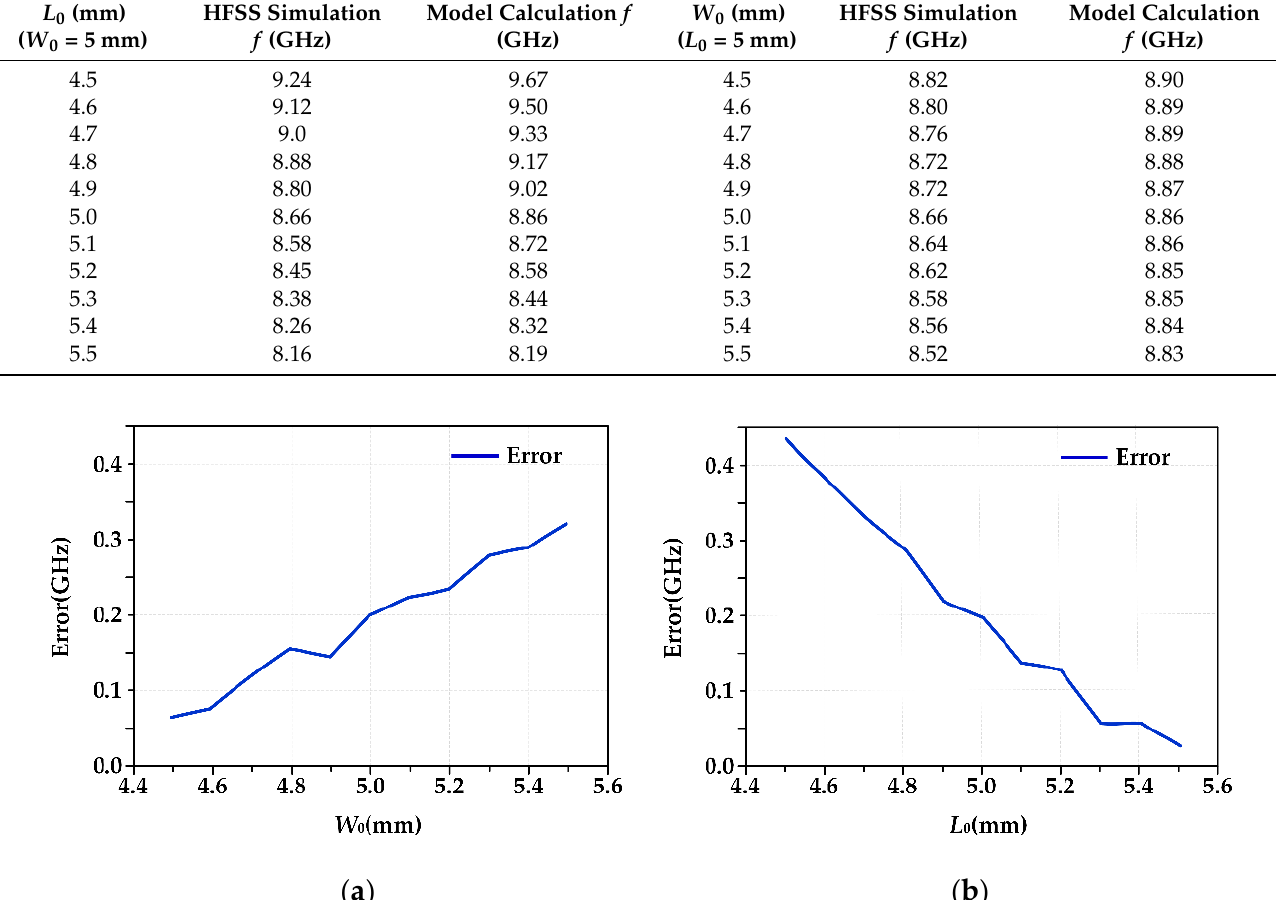
Table 7. HFSS simulation results and coupling model calculation results of different W 0 and L 0 parameters under Mode 2 antenna.